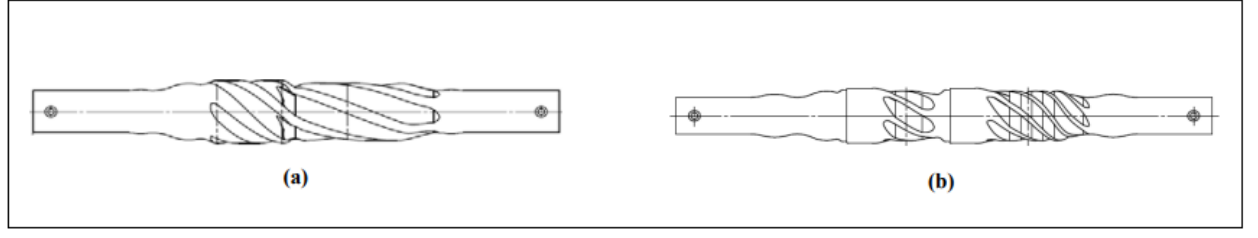
Figure 4. Hydroclean tools: ( a ) first-generation tool (G1) and ( b ) second-generation tool (G2) (Reprinted with permission from Ref. [66]. 2023, Society of Petroleum Engineers”).